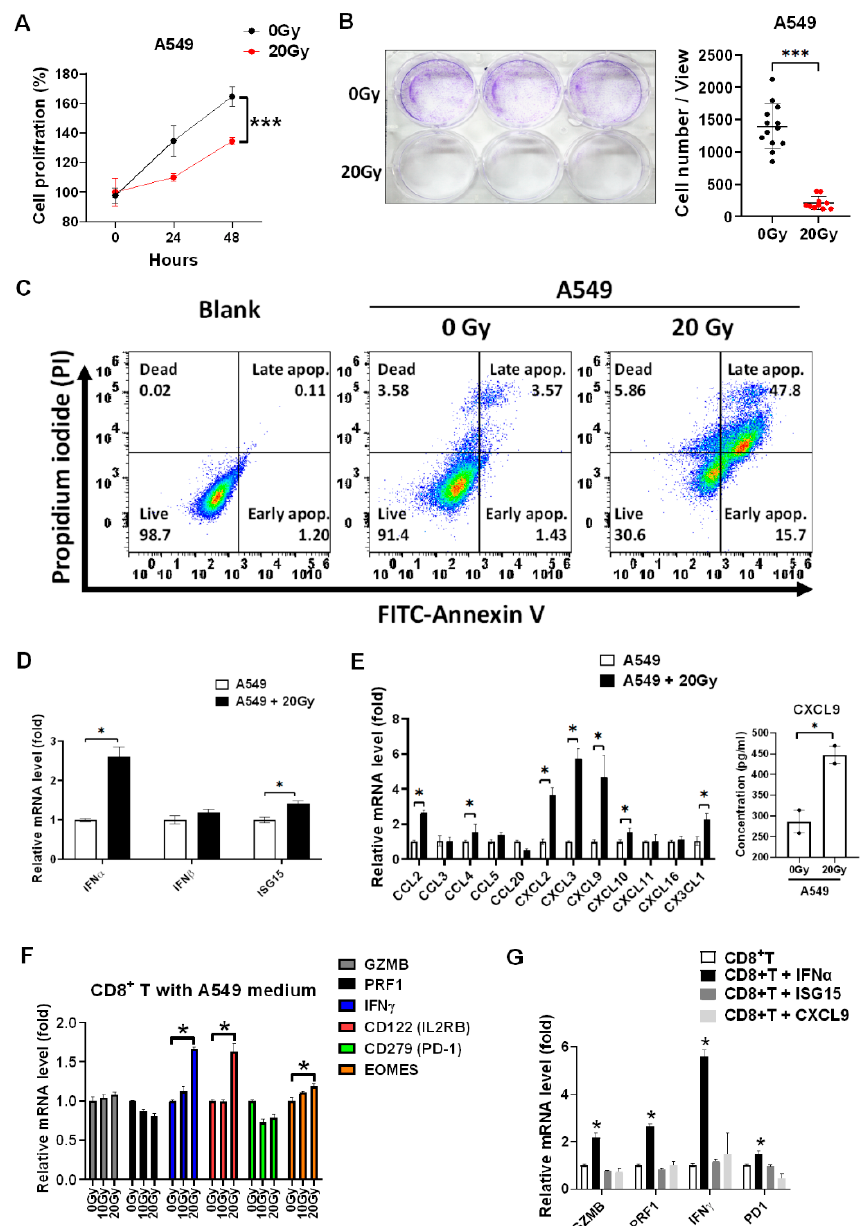
Figure 1. Irradiation inhibits A549 tumor growth and induces IFN α and chemokines overexpression to increase CD8 + T cell activity. ( A ) Cell viability was detected in A549 treated with 20 Gy of irradiation in a time-dependent manner. The quantification was calculated based on 3-times repeat. ( B ) Colony formation with 3-times repeat was measured in A549 treated with irradiation 7 days later. ( C ) Annexin V-labeled FITC was used to measure cell apoptosis in A549 treated with irradiation 24 h later using flow cytometry. ( D ) The type I interferons including α and β subtype and radiotherapeutic marker ISG15 were detected using qPCR in A549 treated with 20 Gy of irradiation 24 h later. ( E ) Meanwhile, the chemokines associating with CD8 + T lymphocyte trafficking were detected in A549 treated with irradiation 24 h later using qPCR. In addition, CXCL9 concentration was measured using an ELISA technique in the cultured medium of irradiated A549 cells compared to parental A549 cells. ( F ) The A549 cultured medium after irradiation treatment was collected and incubated with PBMCs for 24 h and CD8 + T cells were consequently isolated for further investigation for the cellular levels of cytotoxic marker GZMB , PRF1 , activation marker IFN γ , CD122 , EOMES , and inhibitory marker CD279 (PD-1) using qPCR. ( G ) IFN α , ISG15, and CXCL9 (20 ng/mL) were selected